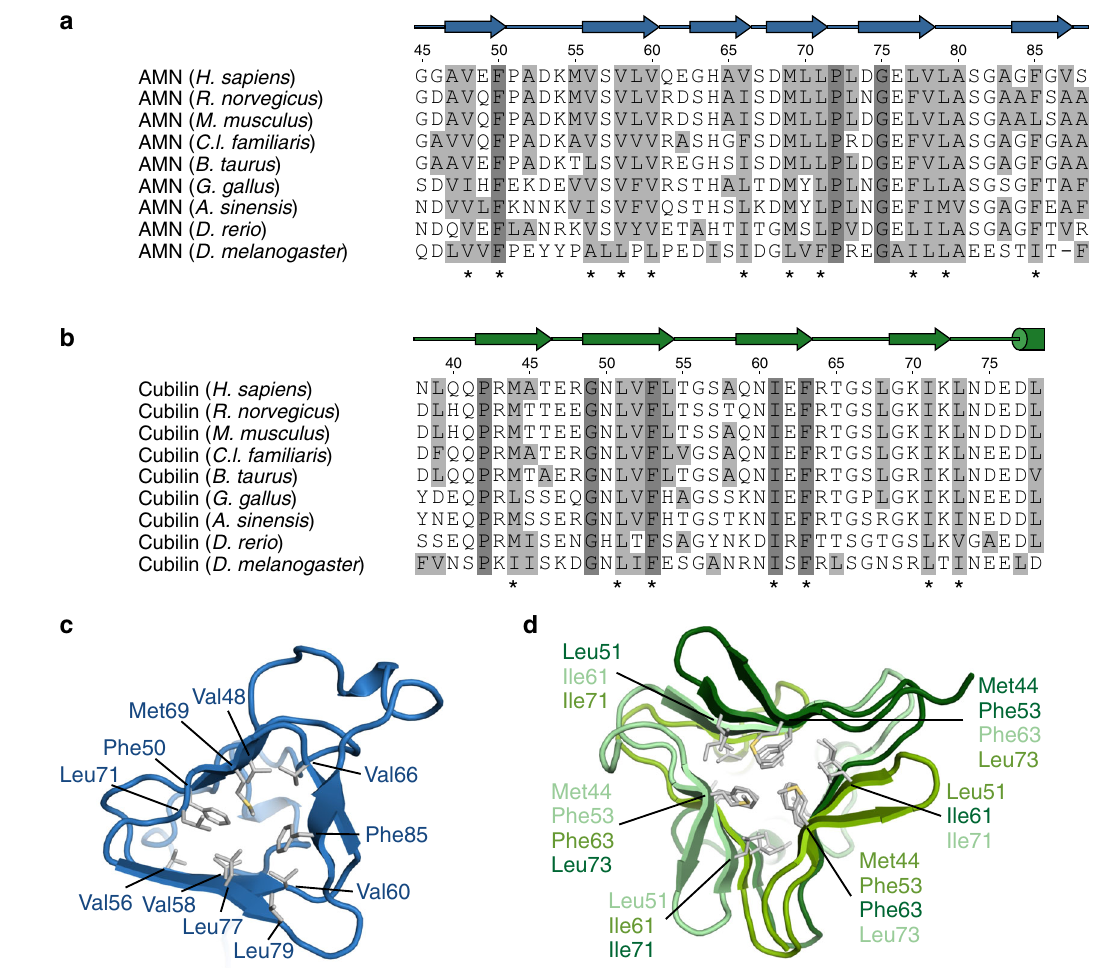
Fig. 3 Sequence alignment of AMN and cubilin β -helices. a Sequence alignment of AMN β -helix 1. b Sequence alignment of the cubilin β -helix. Secondary structure elements are shown above the alignment. Fully conserved residues are marked by dark grey boxes. Hydrophobic residues (Ala, Val, Leu, Ile, Met, Phe) are marked by light grey boxes. Residues constituting the core of the β -helices are marked by asterisks below the alignment. c and d Cartoon representation of AMN β -helix 1 ( c ) and the cubilin β -helix ( d ). Hydrophobic residues forming the core of the β -helices are shown as grey